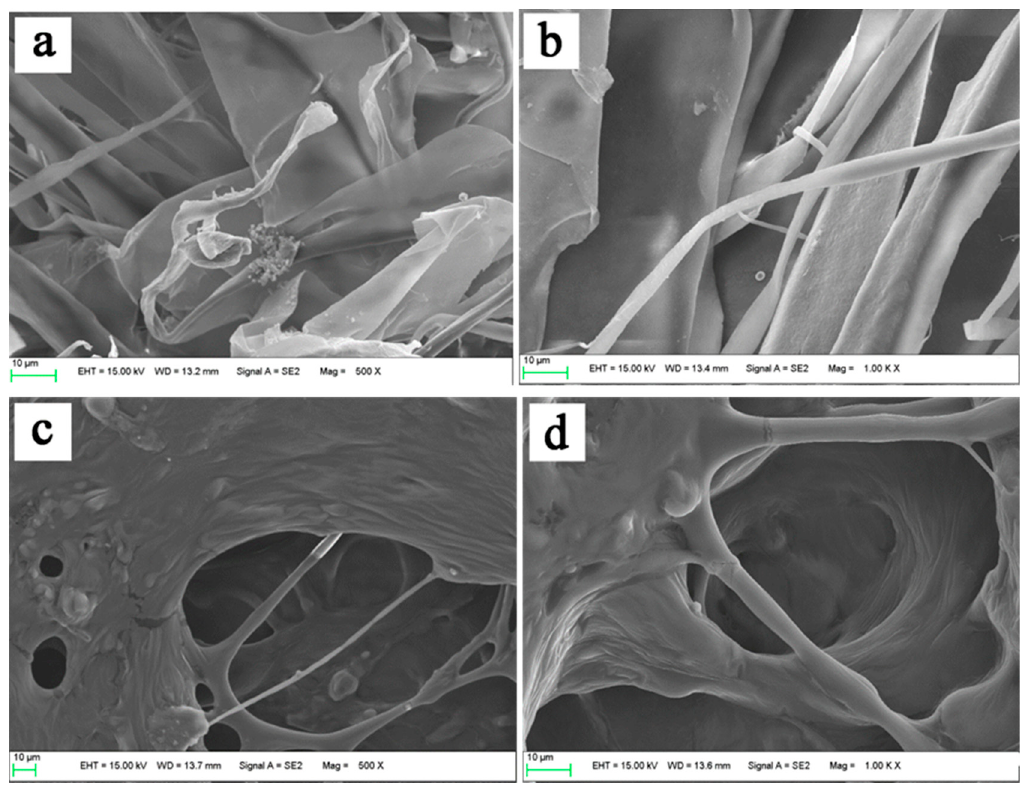
Figure 3. Scanning electron microscopic plates exhibiting the micro-structure of GSC ( a , b ) and PSC ( c , d ) isolated from surf clam shell ( Coelomactra antiquata ).